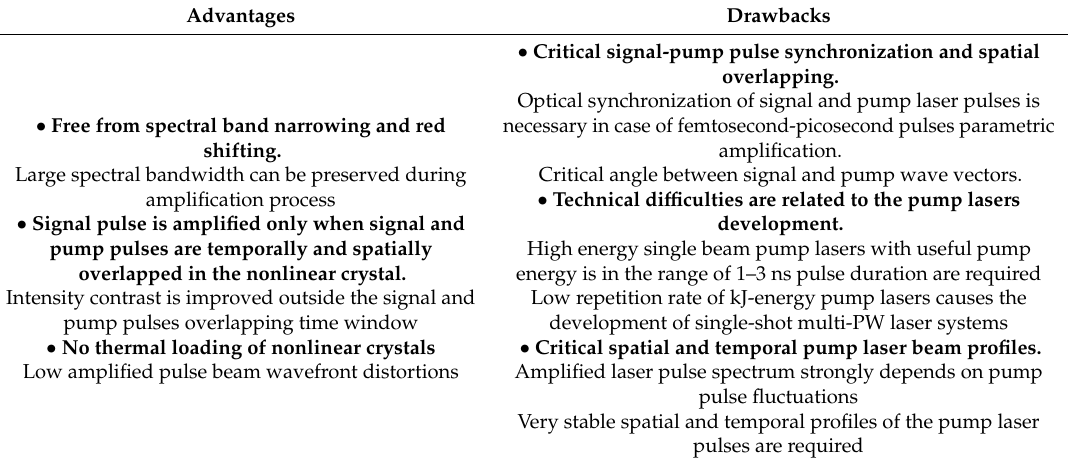
Table 6. The advantages and drawbacks of OPCPA in large size nonlinear